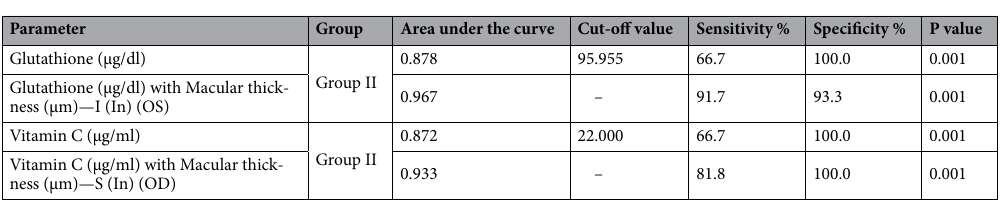
Table 9. Combined